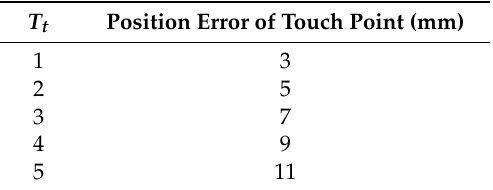
Table 2. Position errors according to T t in touch region detection.